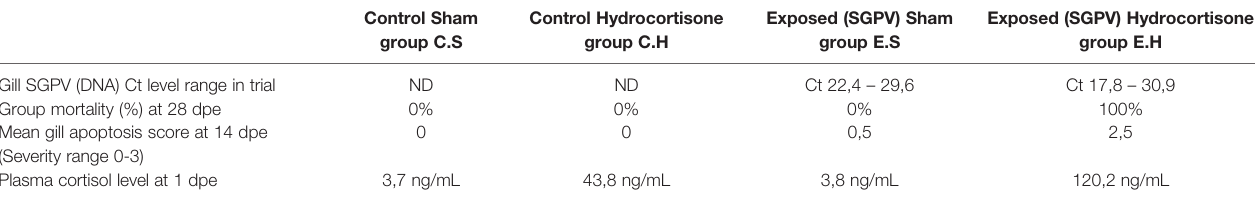
TABLE 1 | A summary of trial information derived from (24). The trial lasted for 28 days after SGPV infection. Hydrocortisone injection was given 24 hours earlier (day -1). Dpe; Days post exposure. Control Sham group